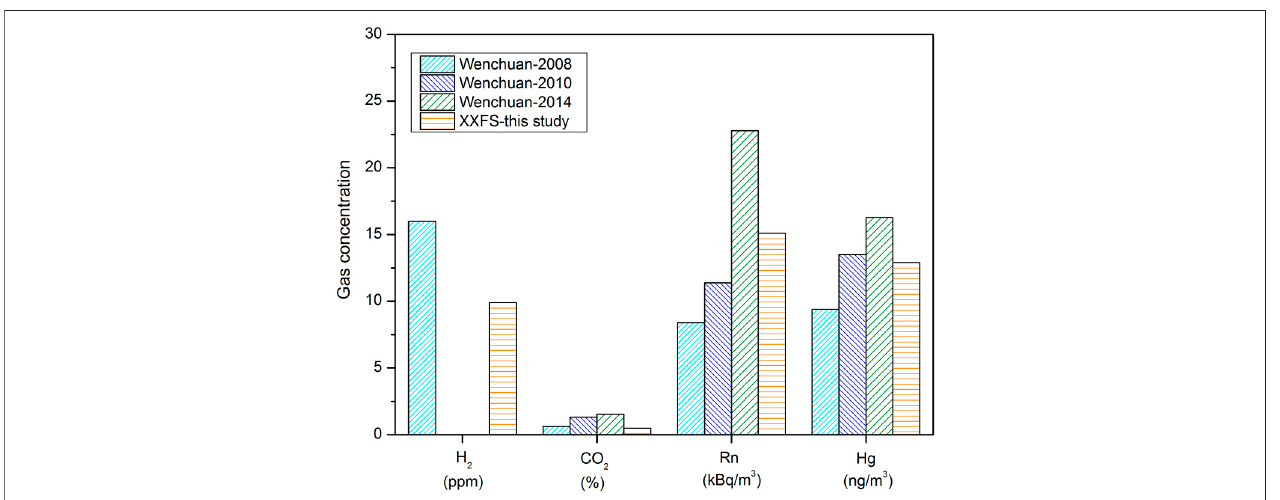
FIGURE 4| Comparations of H 2 , CO 2 , Rn, and Hg concentrations in the XXFS and the surface rupture zone produced by the Wenchuan Ms 8.0 earthquake. Data sources: Zhou et al. (2010); Zhou et al. (2015); Zhou et al. (2016).